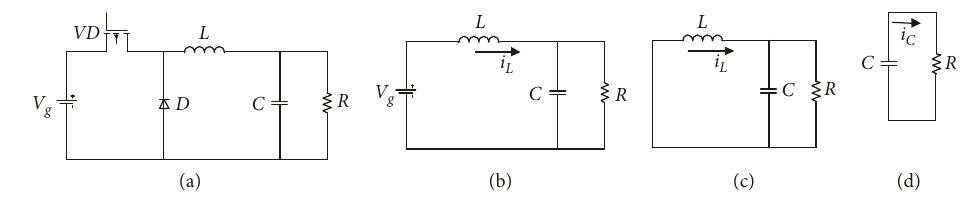
Figure 1: Buck converter working state equivalent